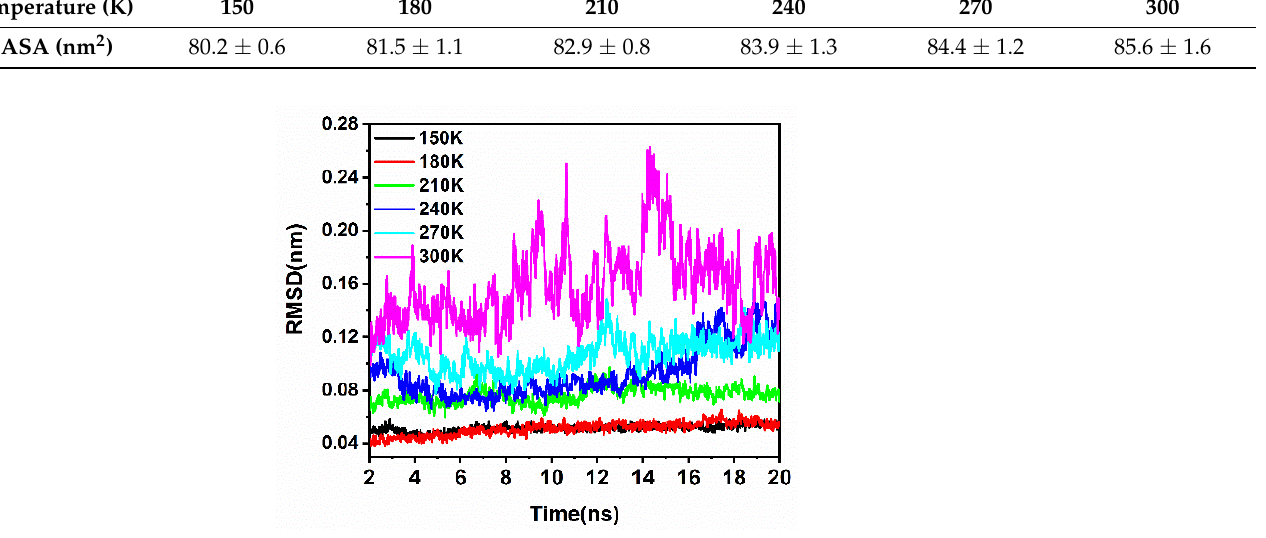
Figure 3. The RMSD of C α in SN0 at different temperatures during 20ns simulations.